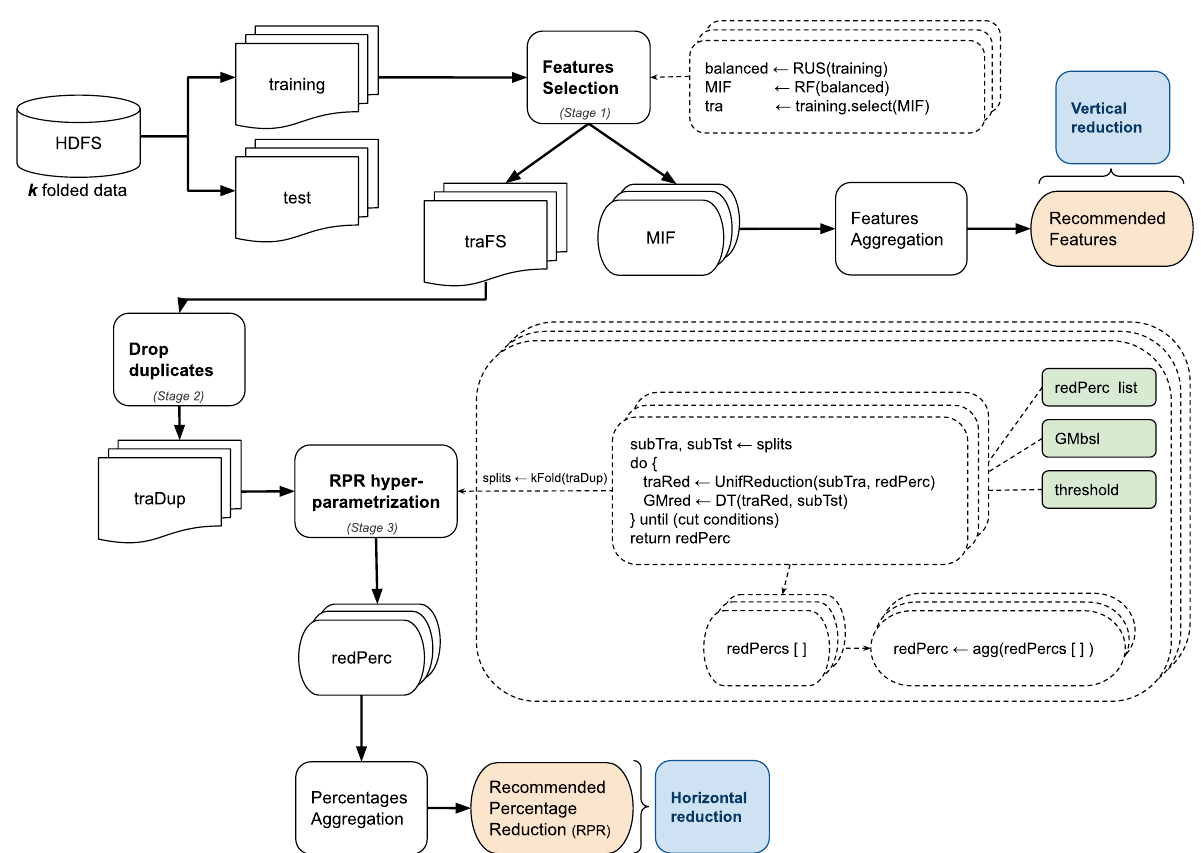
Figure 1. The FDR 2 -BD’s workflow showing the three main stages of the